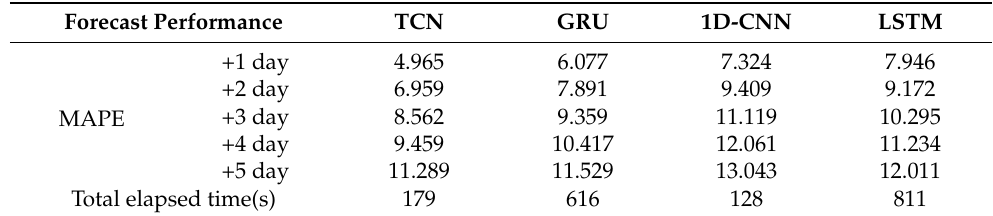
Table 2. Comparison of multi-step prediction performances (MAPE) and elapsed time of several models.